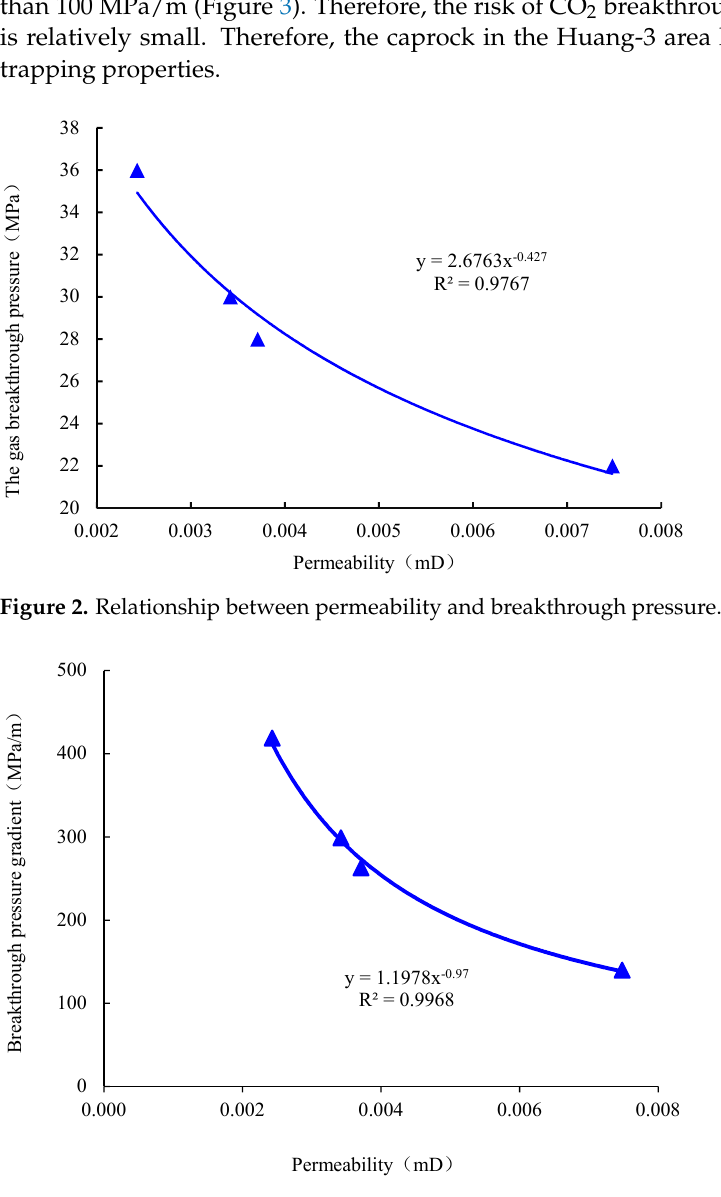
Figure 3. Relationship between permeability and breakthrough pressure gradient.